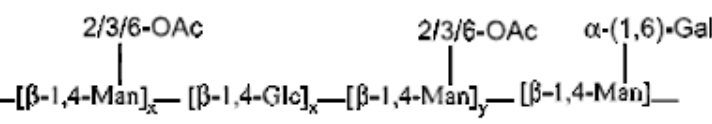
Figure 2. Chemical structure of acemannan